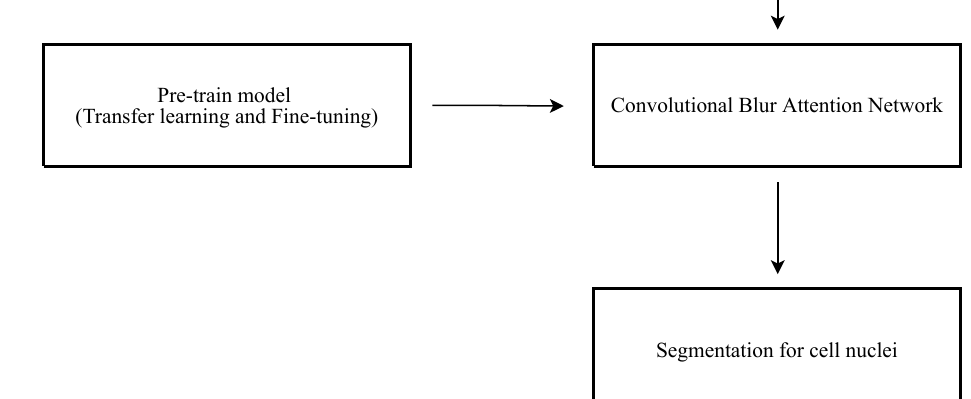
Figure 2. The flowchart of the proposed method.